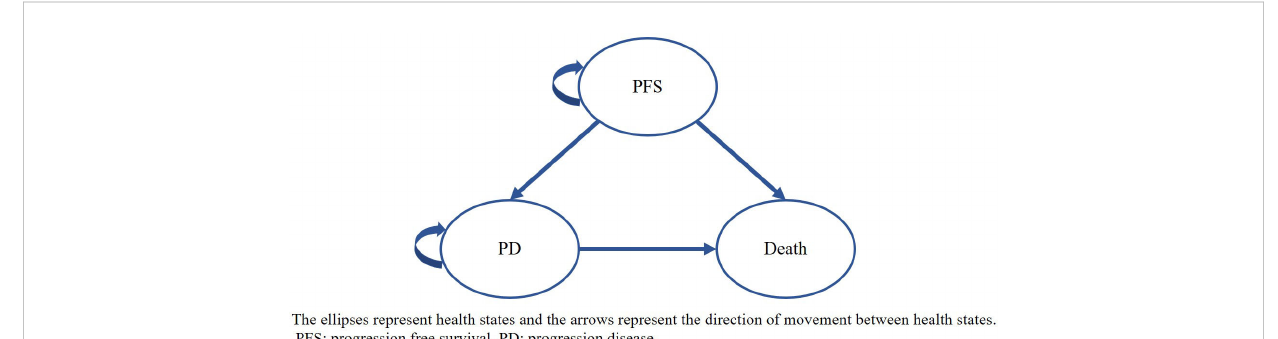
FIGURE 1 Markov model structure The ellipses represent health states and the arrows represent the direction of movement between health states. PFS: progression free survival, PD, progression